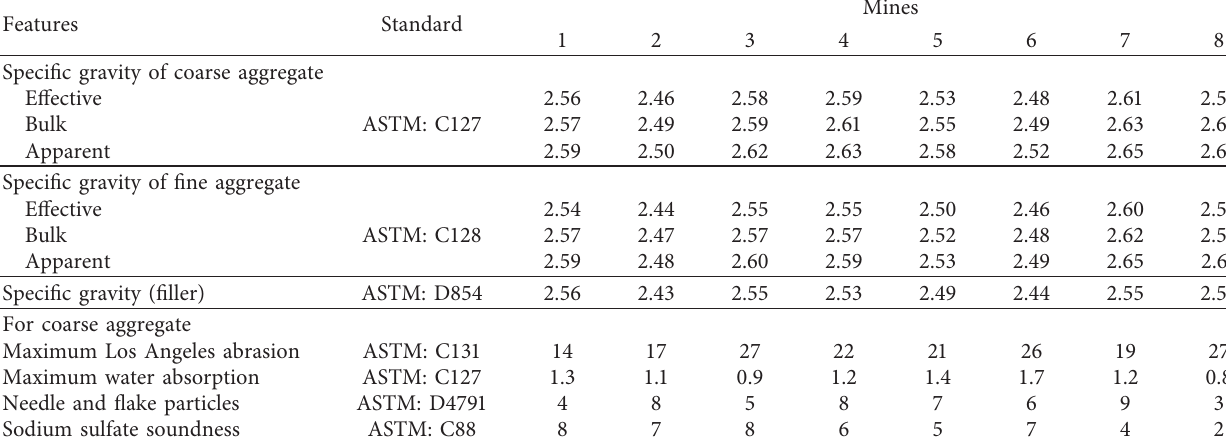
Table 1: The physical features of the aggregates.